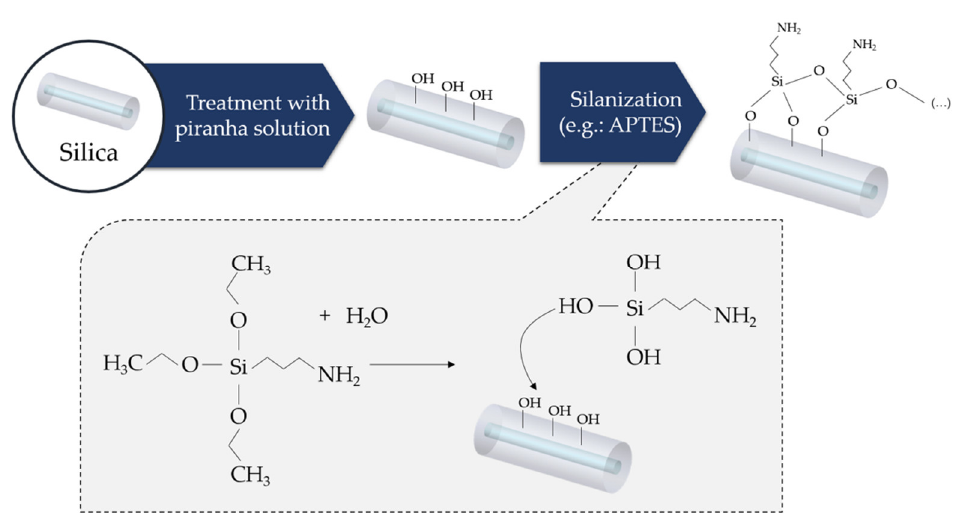
Figure 8. Schematic representation of an SOF surface modification using a silane as an intermediary linker to produce an amine-terminated surface.